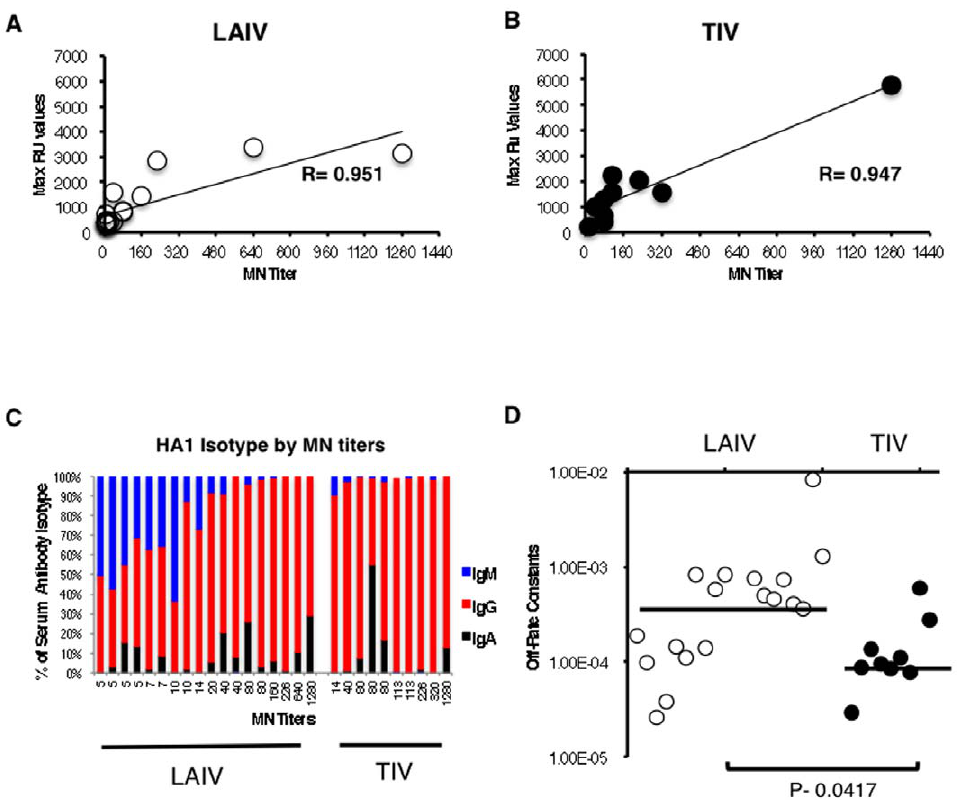
Figure 3. Affinity measurements isotyping and total anti-HA1 binding antibody in human sera following immunization. (A–B) Correlation between in vitro MN titers and rHA1 binding in human sera following immunization with H1N1 vaccine in TIV and LAIV groups. Steady-state equilibrium analysis of the binding of vaccine serum IgG to properly folded functional HA1 oligomers was measured using surface plasmon resonance (SPR). Ten-fold diluted post-H1N1 vaccination sera from vaccine groups (LAIV in A, TIV in B) were injected simultaneously onto HA1 immobilized on a sensor chip, free of peptide. Binding was recorded in resonance units (RU) values. The maximum RU values for HA1 binding by serum antibodies obtained from vaccinated individuals with either LIAV (A) or TIV (B) vaccination is shown on the Y-axis. The MN titer is expressed as end-point neutralizing antibody titer of post-H1N1 vaccine sera and is depicted on the X-axis. (C) The isotype of serum antibodies bound to rHA1 for the two vaccine groups. Data shown are the means for serum from two independent experiments. (D) Antibody avidity measurements in polyclonal serum by off-rate constants using SPR. Antibody off-rate constants, which describe the stability of the complex were determined directly from the serum/plasma sample interaction with rHA1 protein using SPR in the dissociation phase. For accurate measurements, parallel lines in the dissociation phase for the 10-fold and 100-fold dilution for each post-vaccination human sera were required. The off-rate constants were determined from two independent SPR runs. SPR analysis of post-vaccinated human sera with LAIV (left) or TIV (right) from the vaccine trial was performed with properly folded H1N1pdm09 HA1 (A/CA/7/2009) [60]. Serum antibody off-rate constants for vaccinees (each symbol is one individual) were plotted. Correlation statistics of affinity measurement and off-rate constants of sera binding to rHA1 between LAIV and TIV vaccinees were statistically significant with p , 0.05 (T-test).